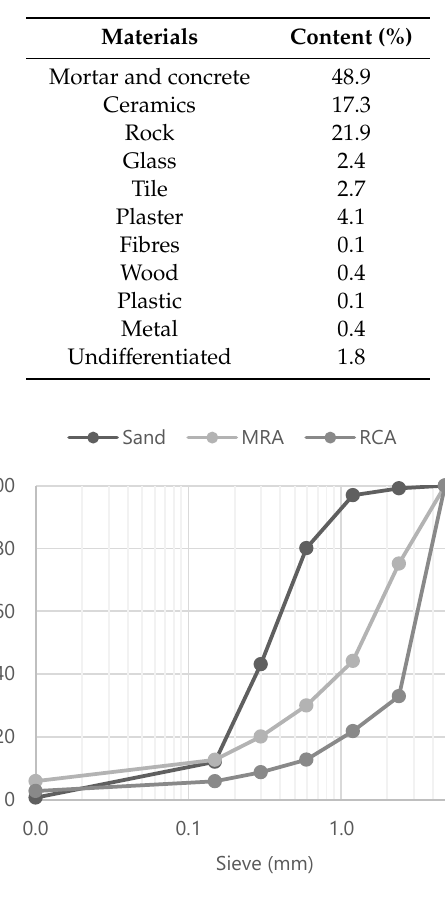
Table 3. Materials identified in mixed recycled aggregate (MRA) composition.